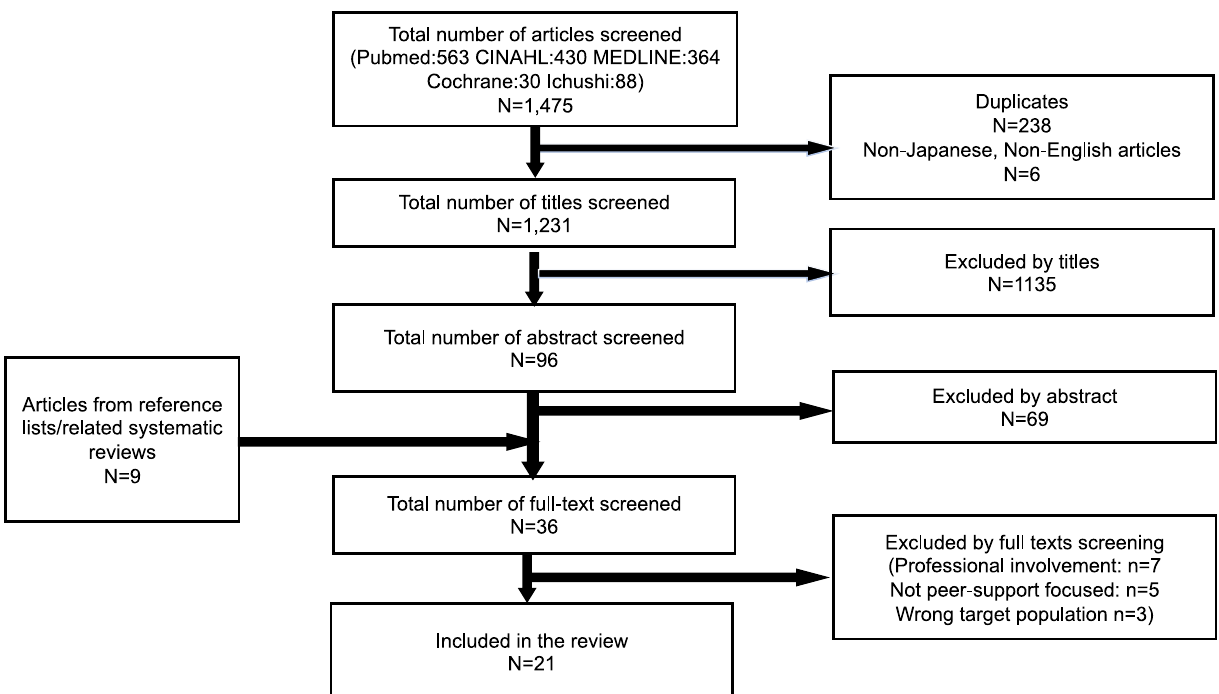
Figure 1. Publication Screening Process